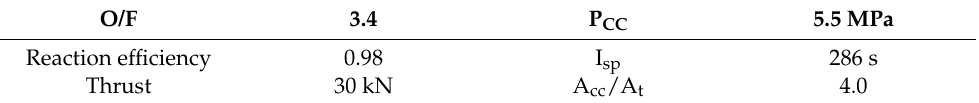
Figure 2. DEMO thrust chamber assembly view with the main components. Table 1. HYPROB (HYdrocarbon PROpulsion test Bench) DEMO main performance parameters.